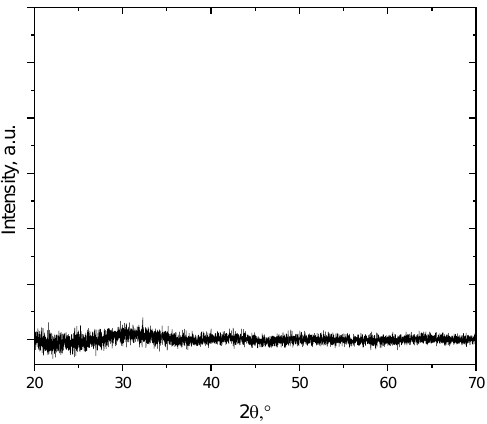
Figure 3. XRD pattern spectra of amorphous TiO 2 without dopants.